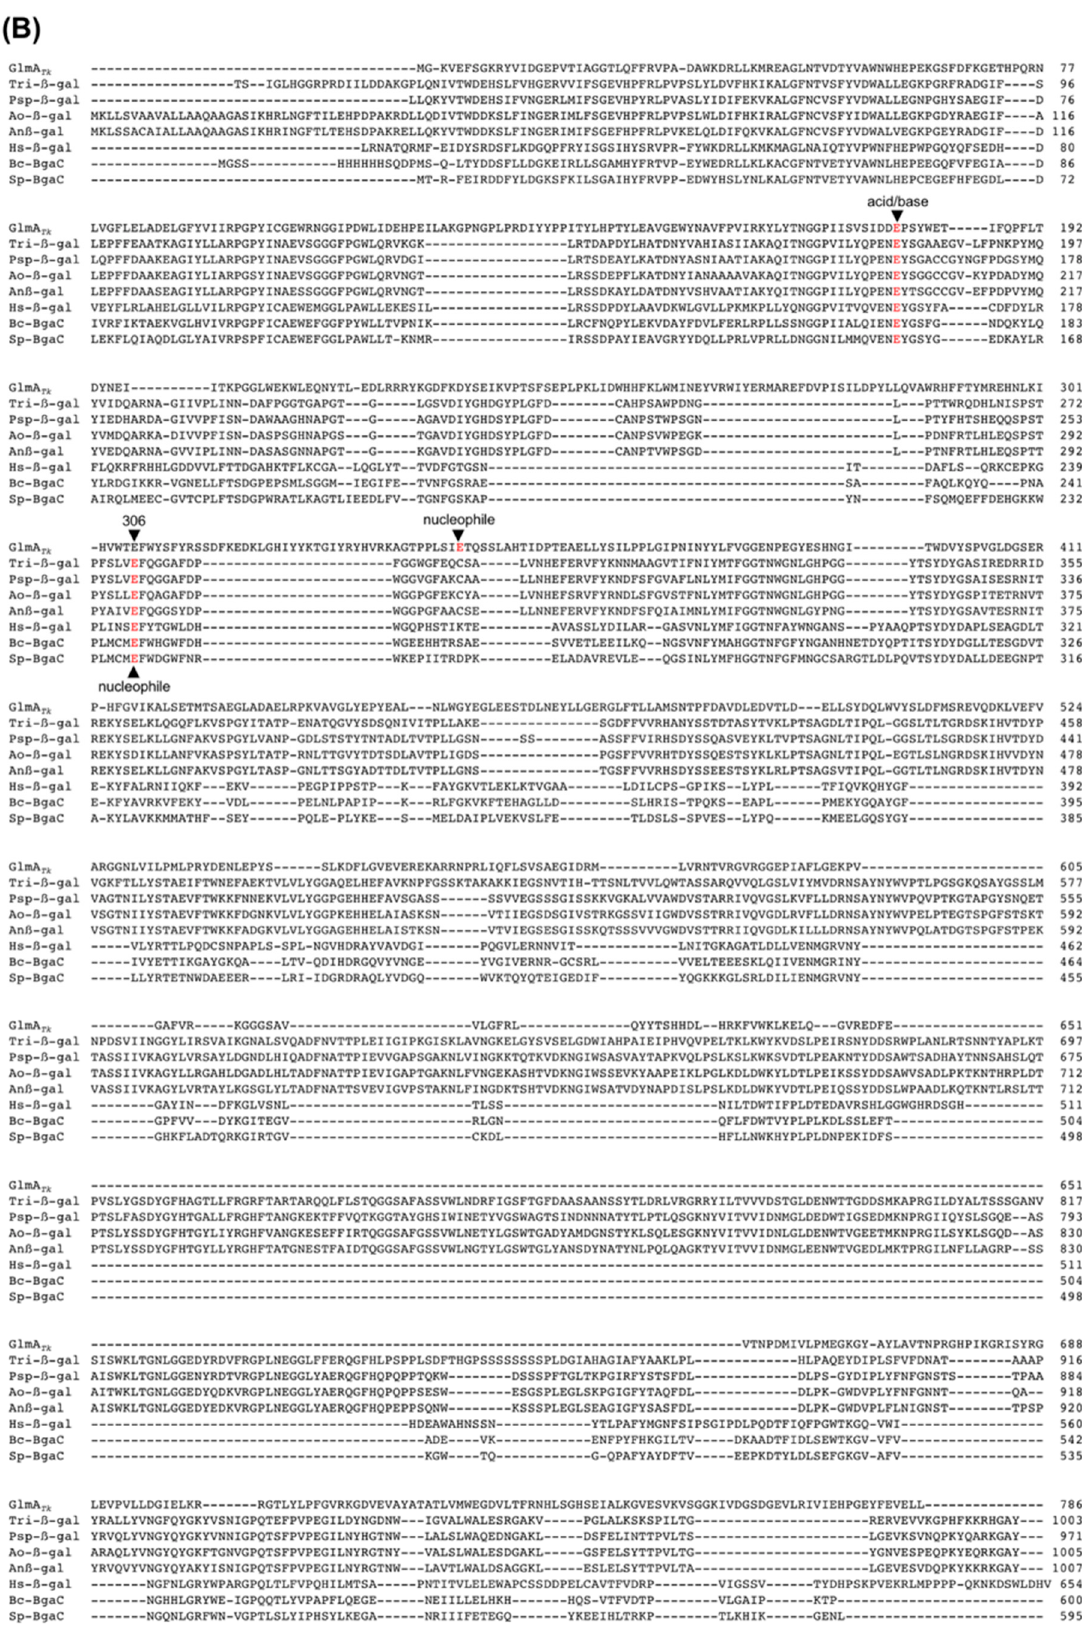
Figure 5. Sequence alignment of the catalytic residues (red) of GH42 β -galactosidases ( A ) and GH35 β -galactosidases ( B ). Alignments were carried out with ClustalW [38].